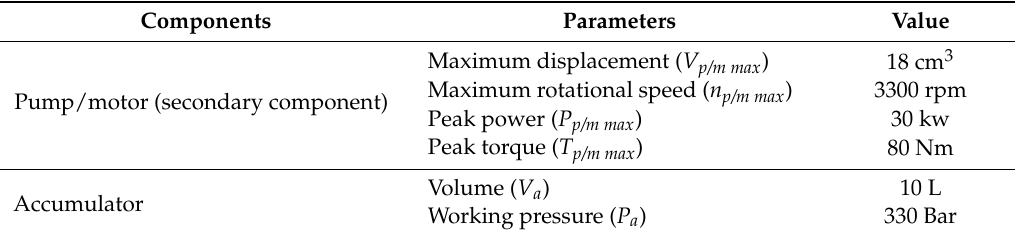
Table 3. Fundamental parameters of the hydraulic system.